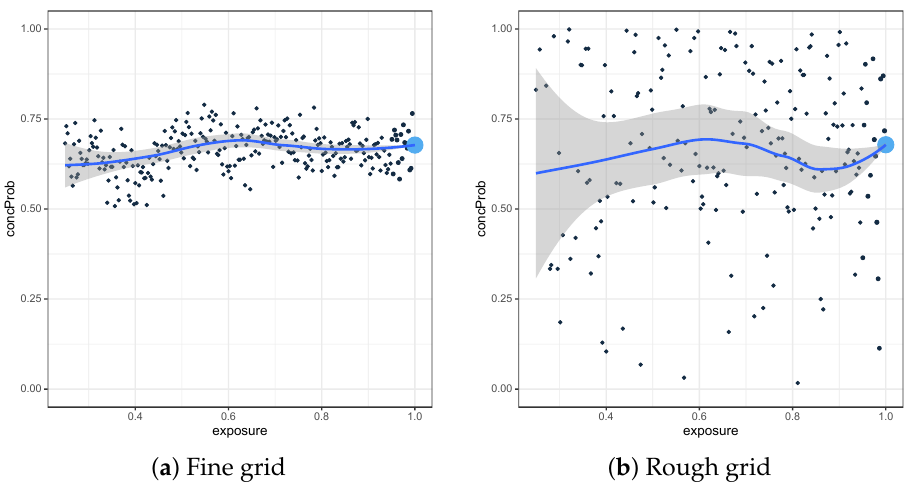
( λ ,0.05 ) in function of the exposure λ , for the 0,1 +